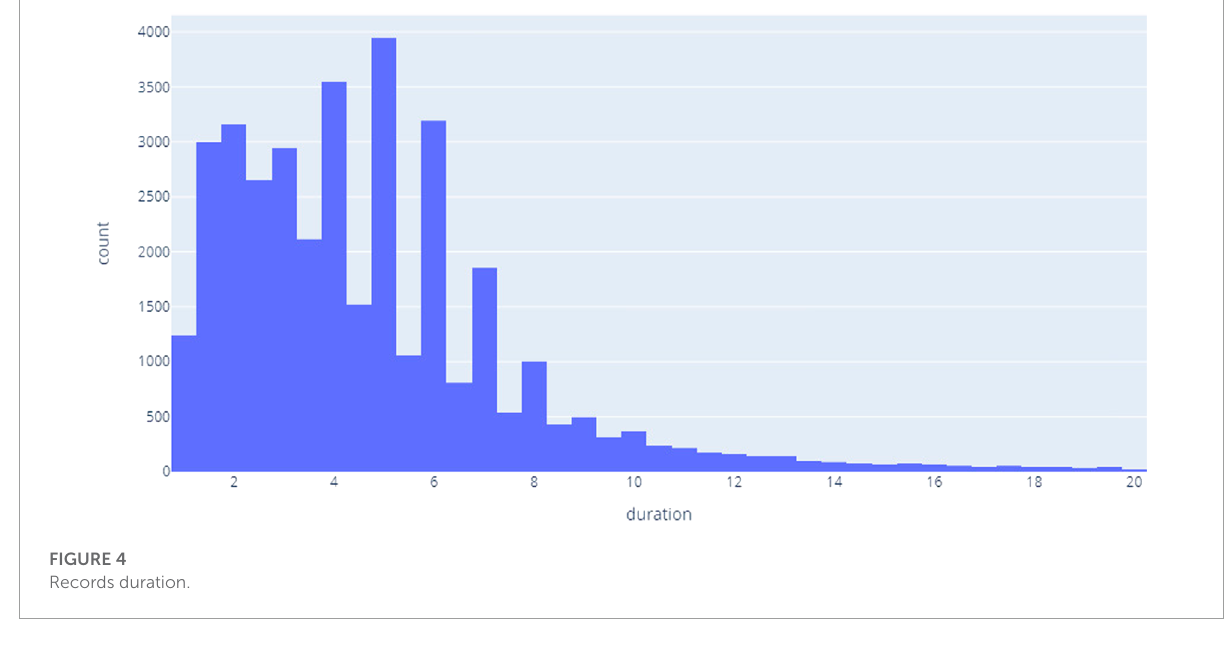
FIGURE 4 Records duration.